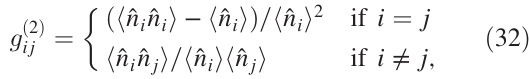
Fig. 3. The different phases obtained from the asymptotic theory are indicated by the colors at the bottom of panel